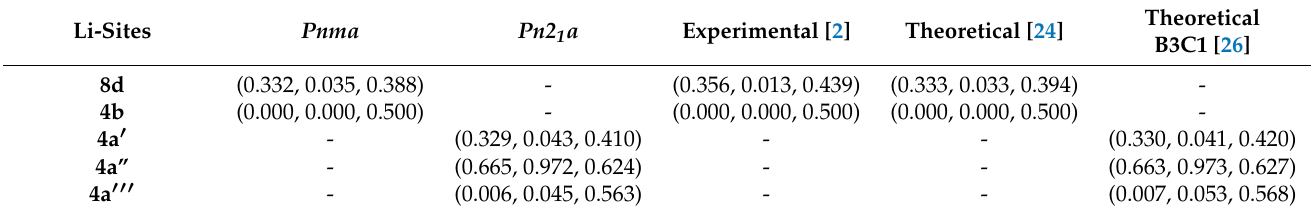
Table 1. Lithium atomic coordinates on β -Li 3 PS 4 for the Pnma and Pn2 1 a structures, compared with literature experimental and theoretical